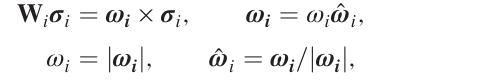
ˆ θ is a unit vector in the direction of increasing θ i